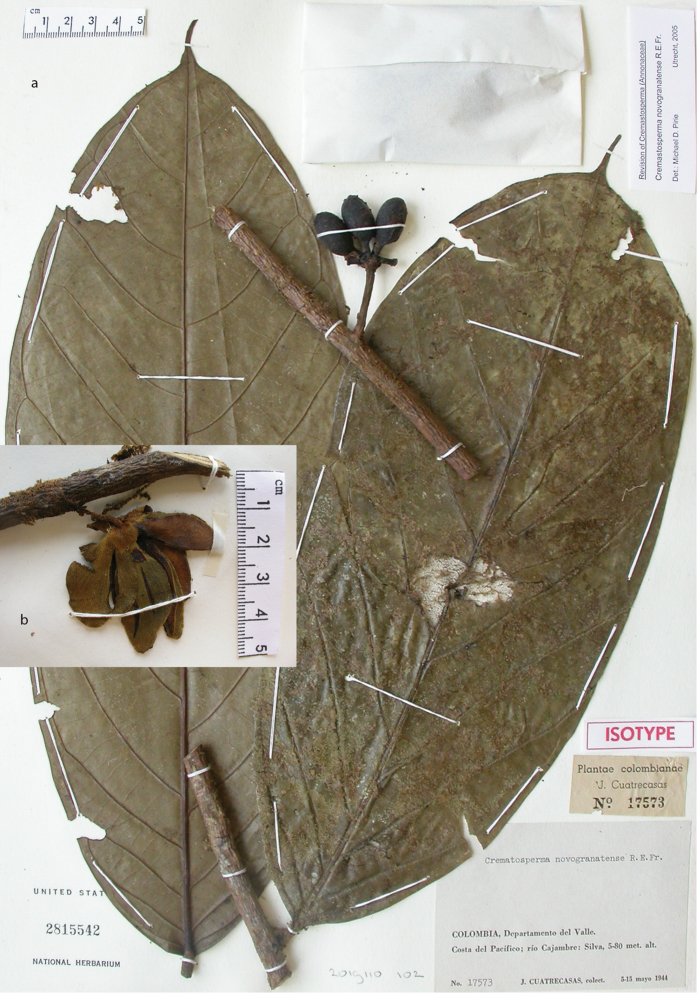
Cremastospermanovogranatense R.E.Fr. a fruiting specimen b flower (aCuatrecasas 17573bCuatrecasas & Willard 26031).